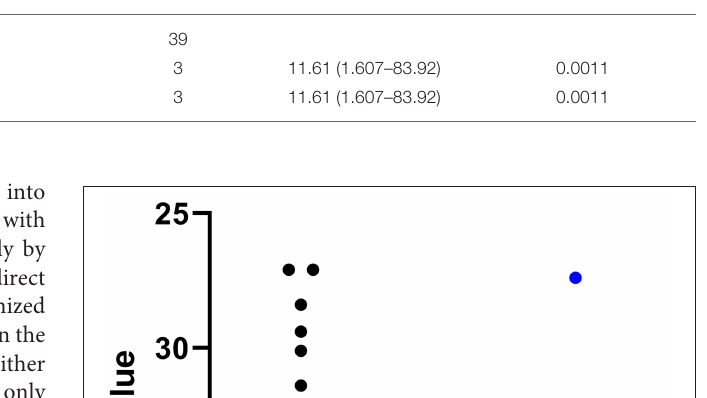
TABLE 1 | Prevention of transmission of SNV via vaccination. Group